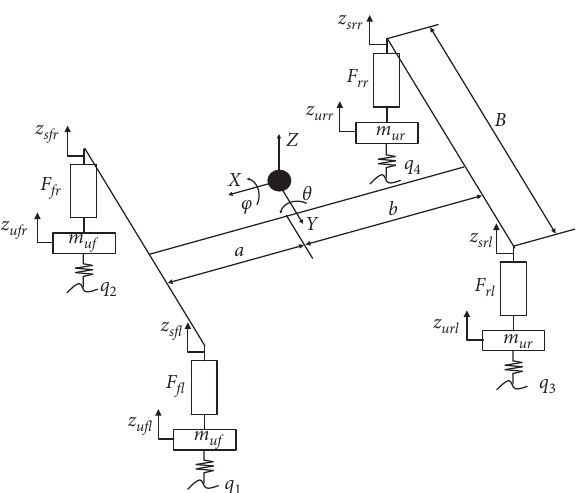
m i is the road excitation; ui is the unsprung mass of the front and rear suspension; f ij is the suspension force, which consists of the stiffness force and the damping force;